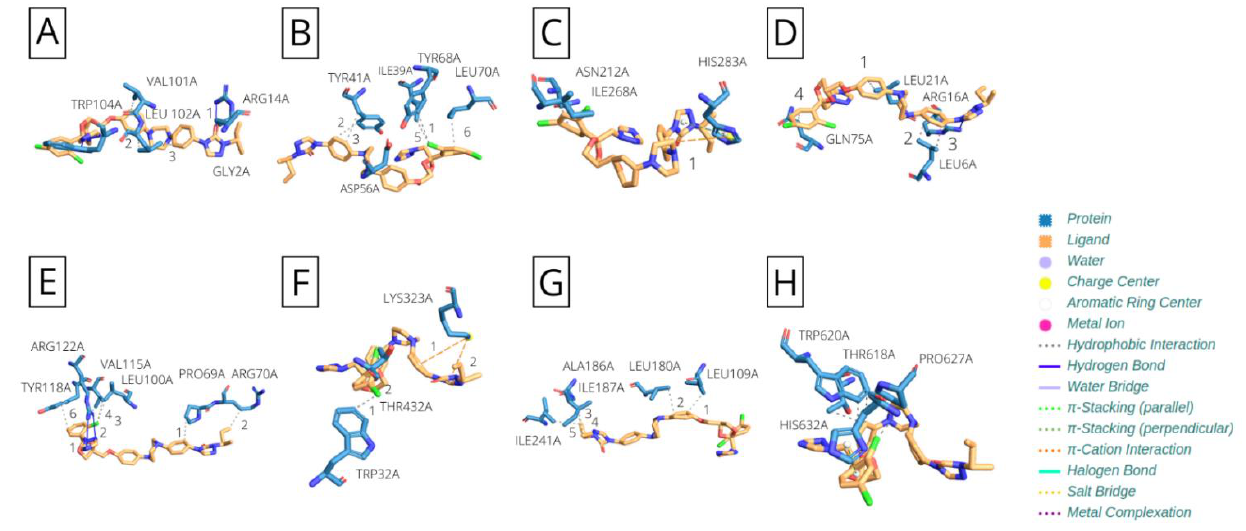
Figure 3. Itraconazole interaction with ROCV proteins. ( A ) Capsid protein; ( B ) polyprotein propep- tide; ( C ) envelope glycoprotein; ( D ) NS2A; ( E ) NS2B; ( F ) NS3; ( G ) NS4B; and ( H ) NS5.